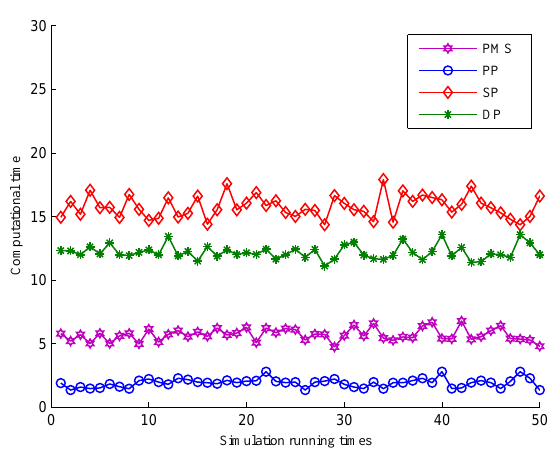
Figure 12. The comparison of four approaches in computation time